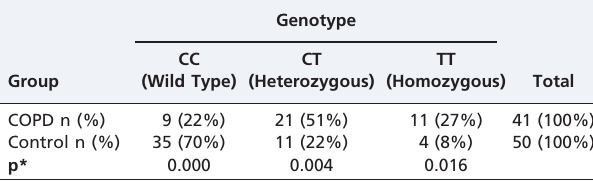
Table 1 - Distribution of MDR-1 (P-glycoprotein, ATP-binding cassette ABC superfamily of membrane transporters) genotypes in patients with COPD and healthy control participants.